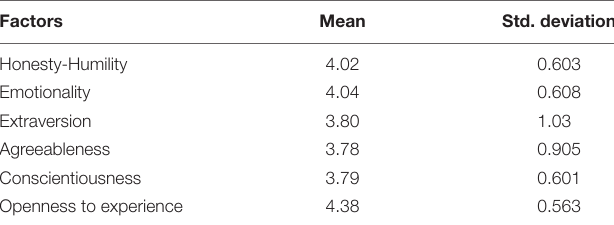
TABLE 4 | Personality traits of higher achievers’ students at the university level. Factors Mean Std. deviation